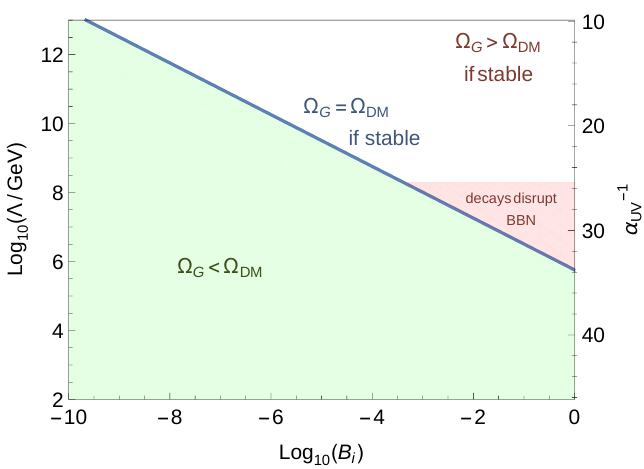
Figure 3 . The (cid:12)nal relic abundance of glueballs produced from a phase transition that happens during a period of matter domination by a gravitationally coupled modulus with mass m X = 10 5 GeV, as a result of energy in the glueball sector remaining from early times. The hidden sector is taken to be an SU (3) gauge group with con(cid:12)nement scale (cid:3), and B i = ( T g =T v ) 4 is (cid:12)xed by its temperature relative to the visible sector before matter domination. The corresponding gauge coupling at a scale 10 16 GeV is shown assuming supersymmetry. If the glueballs are stable, their relic density matches the observed DM value on the blue contours. In parts of parameter space with (cid:3) . m X extra glueballs can be produced by the modulus decay depending on its branching fraction as studied in section 3. For (cid:3) & m X , fast glueball decays to the modulus are possible, depending on the UV theory. These prevent the glueballs being the DM, but avoid cosmological constraints, provided they occur before BBN (the region in which decays through dimension 6 operator generated at a scale 10 16 GeV are dangerous is shaded